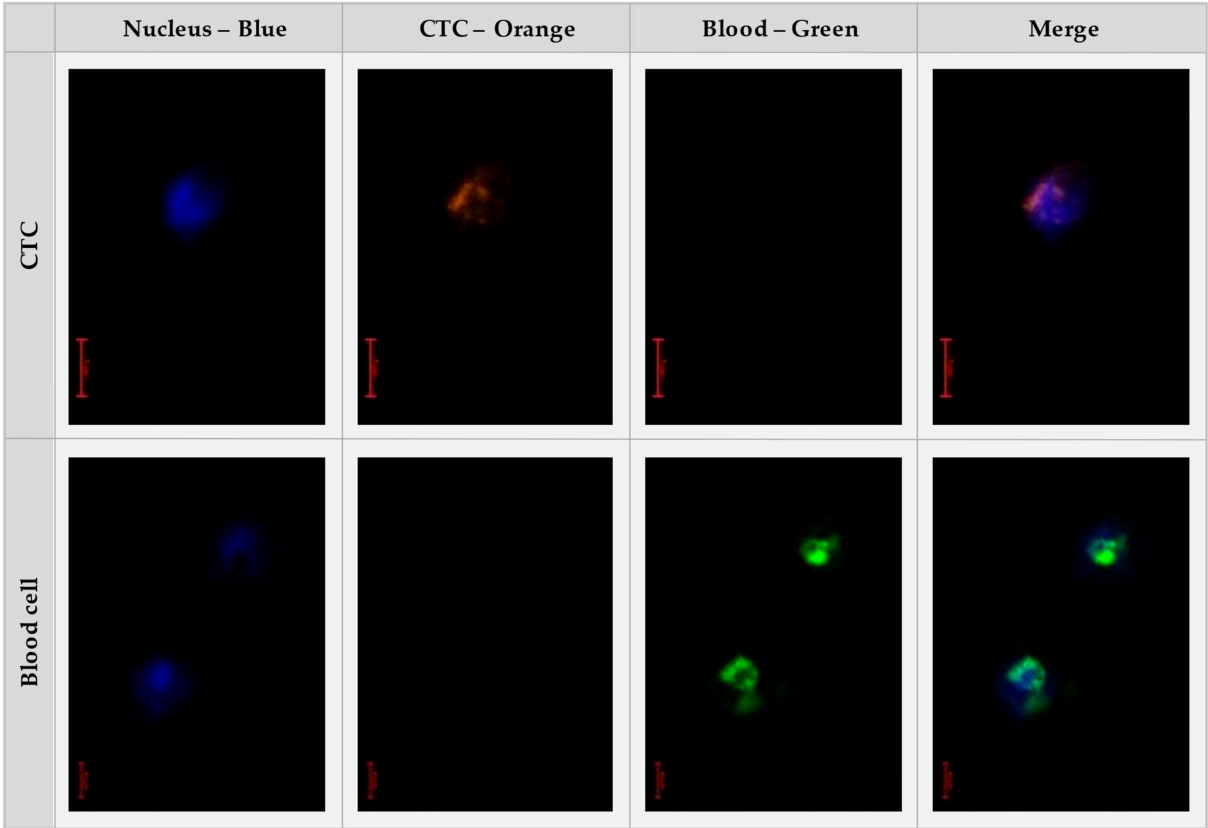
Figure 4. Staining images of a CTC ( top ) and blood cell ( bottom ). The cell nucleus is detected in the blue channel. CTCs are detected in the orange channel and blood cells are detected in the green channel. Finally, the images are superimposed to analyze the shape and position of the different spots.